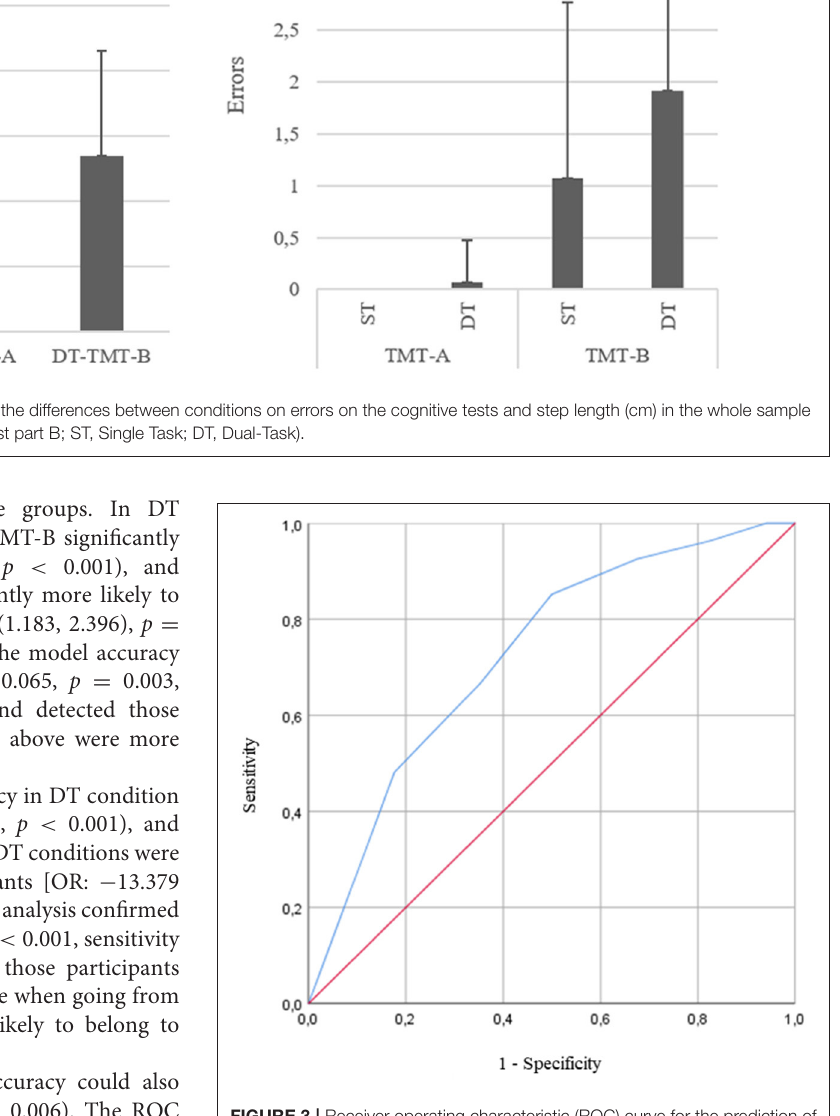
FIGURE 3 | Receiver operating characteristic (ROC) curve for the prediction of the age group based on the number of errors on the Oral Trail Making Test part B (OTMT-B) while walking [area under the curve (AUC) = 0.725 ± 0.065, p = 0.003]. The AUC is equal to 1 for perfect discrimination and 0.5 for an uninformative cutoff point. The optimal cutoff is defined as the value that combined the best combination of sensitivity and